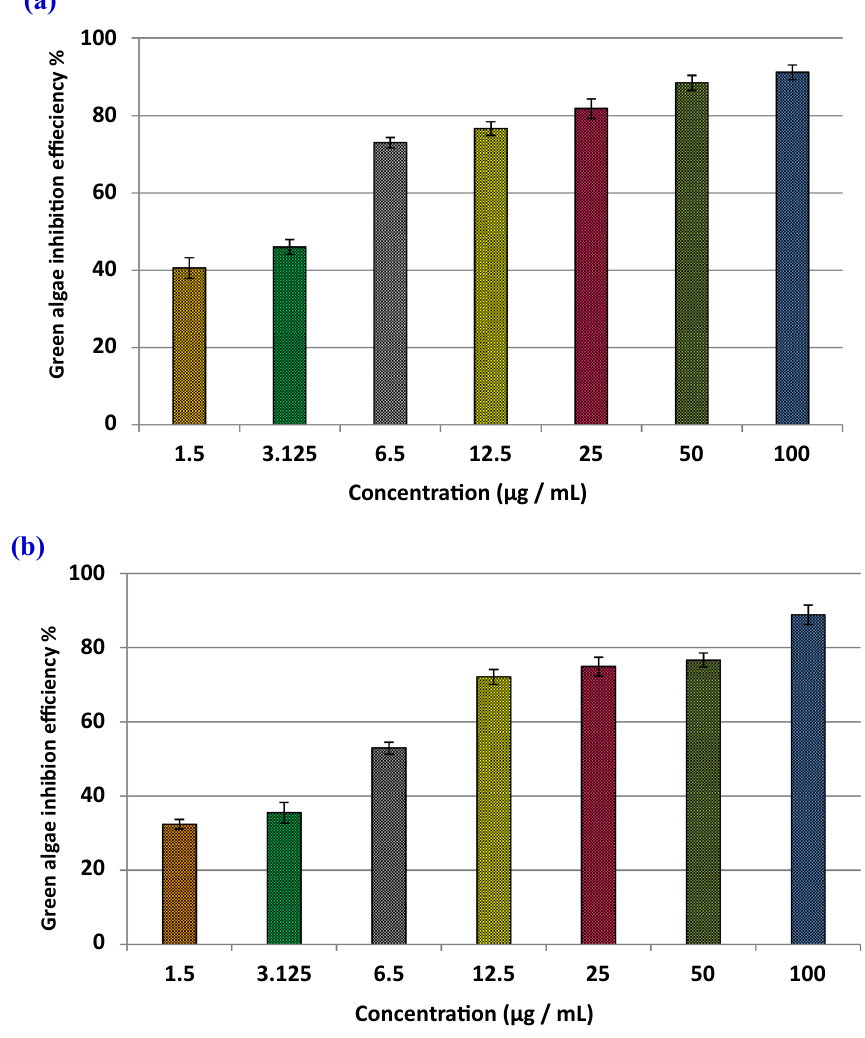
Figure 8. Green algae inhibition efficiency (%) (phycotoxicity) of OG-AgNPs on growth Chlorella vulgaris ( a ) and Chlorella minutissima ( b ), respectively. (data are mean ± standard